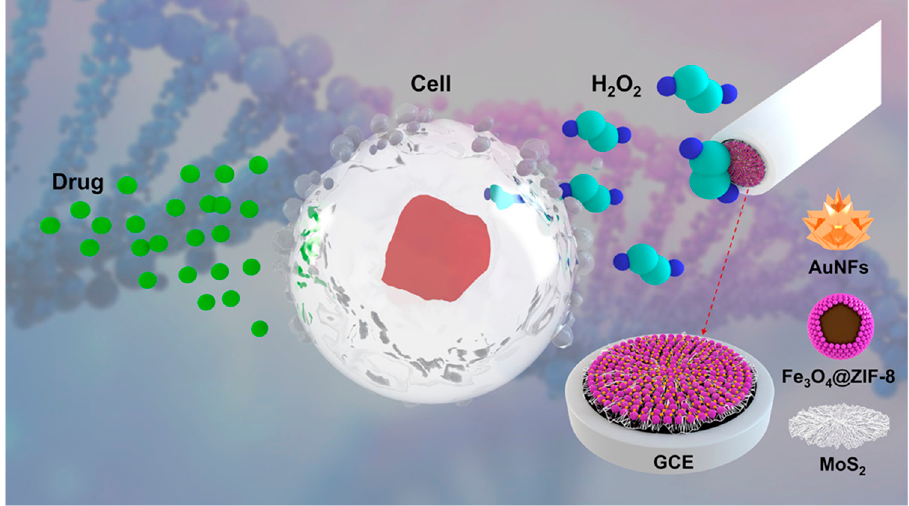
Figure 7. Scheme of an AuNFs/Fe 3 O 4 @ZIF-8-MoS 2 fabricated H 2 O 2 sensor [67]. Copyright: Elsevier B.V.